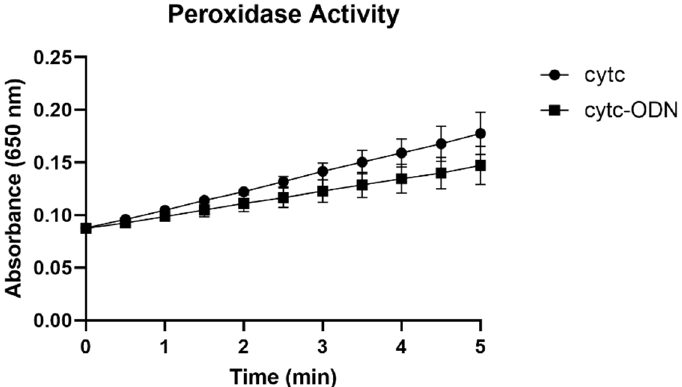
Figure A2. Peroxidase activity of cytochrome c and cytochrome c-conjugated ODN. Kinetic analysis of colorimetric TMB substrate oxidation upon incubation with cytochrome c and cytochrome c-conjugated ODN in the presence of 0.03% H 2 O 2 .